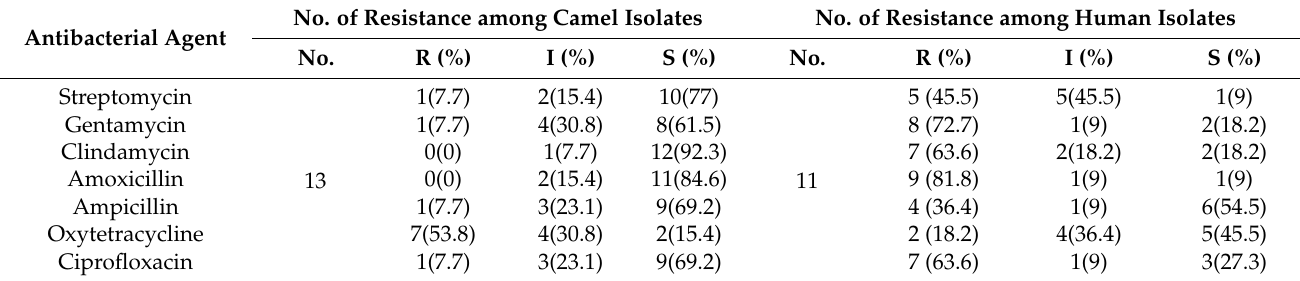
Table 8. Antibiotic sensitivity test for STEC isolates against different antibiotics using CLSI breakpoint [34]. Antibacterial